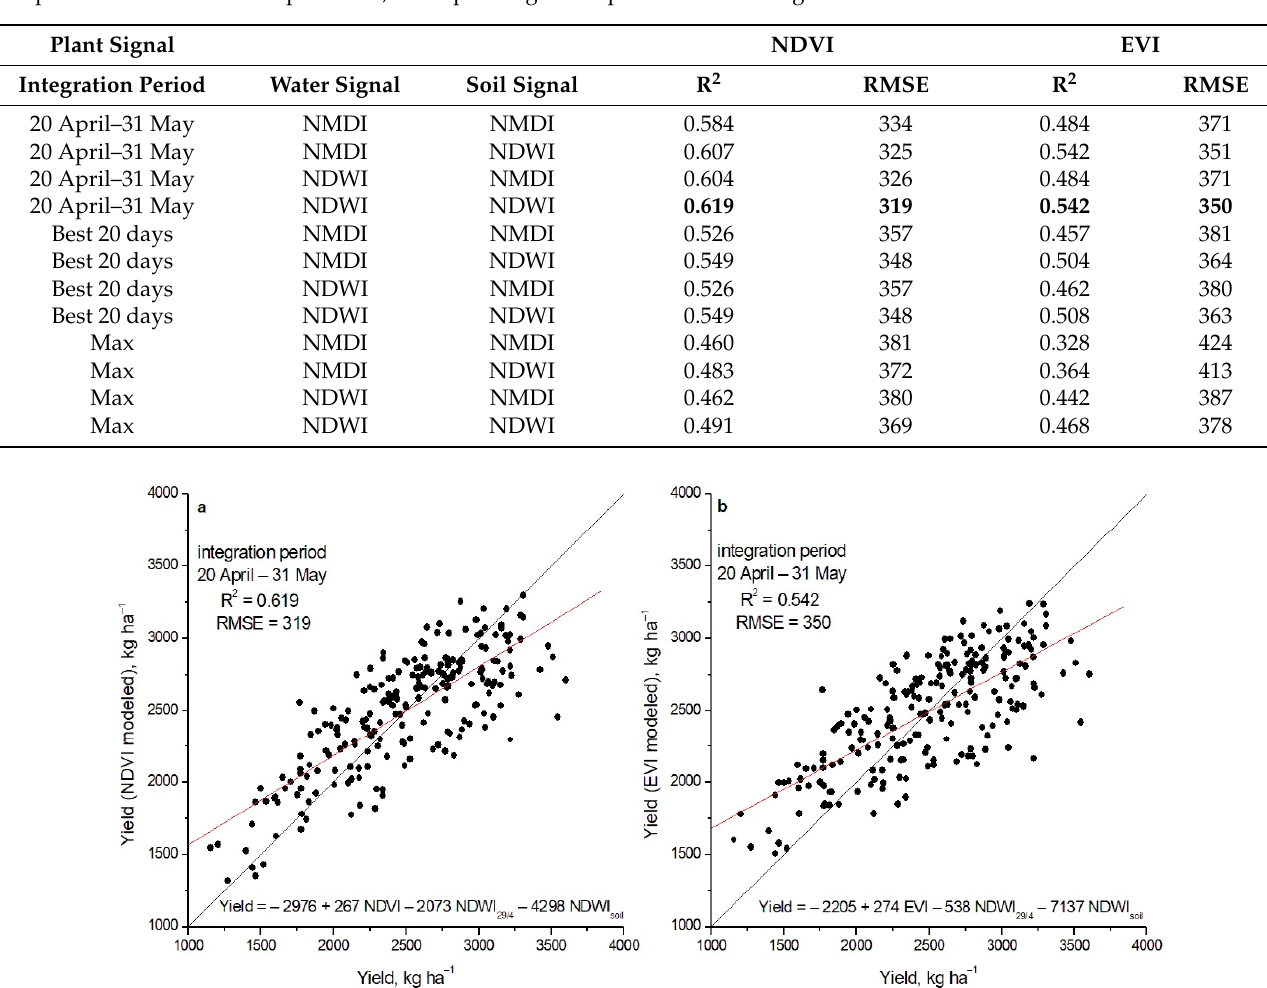
Figure 11. Relationships between measured yield and best model estimates based on NDVI ( a ) or EVI ( b ) as plant signal. For both models, water and soil signals correspond to NDWI on 29 April and NDWI before sowing, respectively. Data concern the pilot field, corresponding to 221 pixels. The black line corresponds to the 1:1 line and the red is the best-fit line. The equations of the modelled yield obtained from the multiple linear regressions are indicated in the